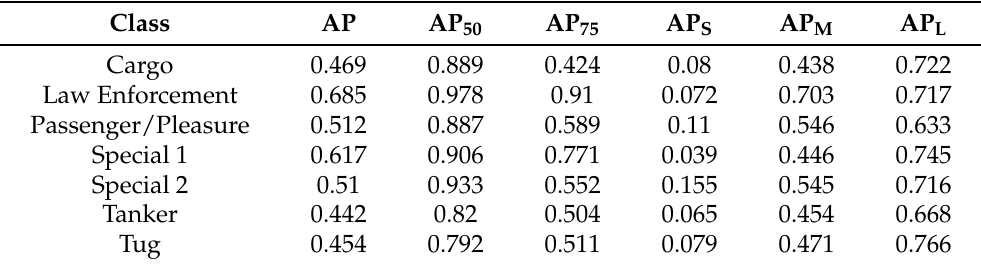
Table A3. Resulting instance segmentation APs per class of the ShipSG dataset using YOLACT 550 , as explained in Section 3.1.